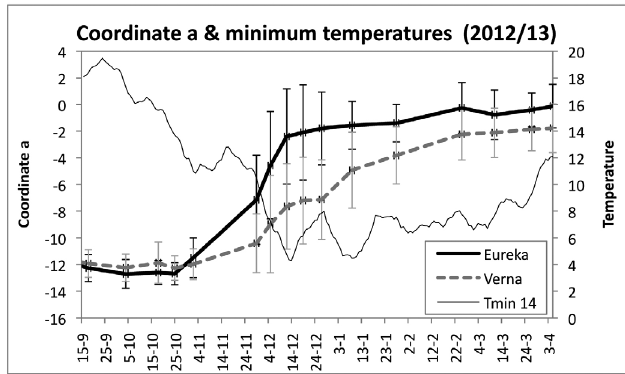
Fig. 2: Evolution of coordinate a (Eureka and Verna cultivars) and mean minimum temperatures and standard deviation of the 14 days from September 2012 to May 2013.